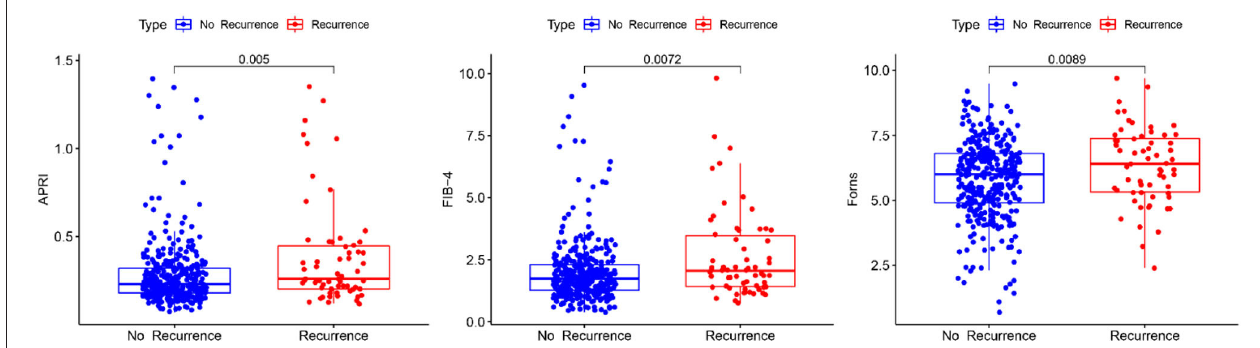
FIGURE 3 | Boxplot of liver fibrosis scores and recurrence in patients with CSDH.